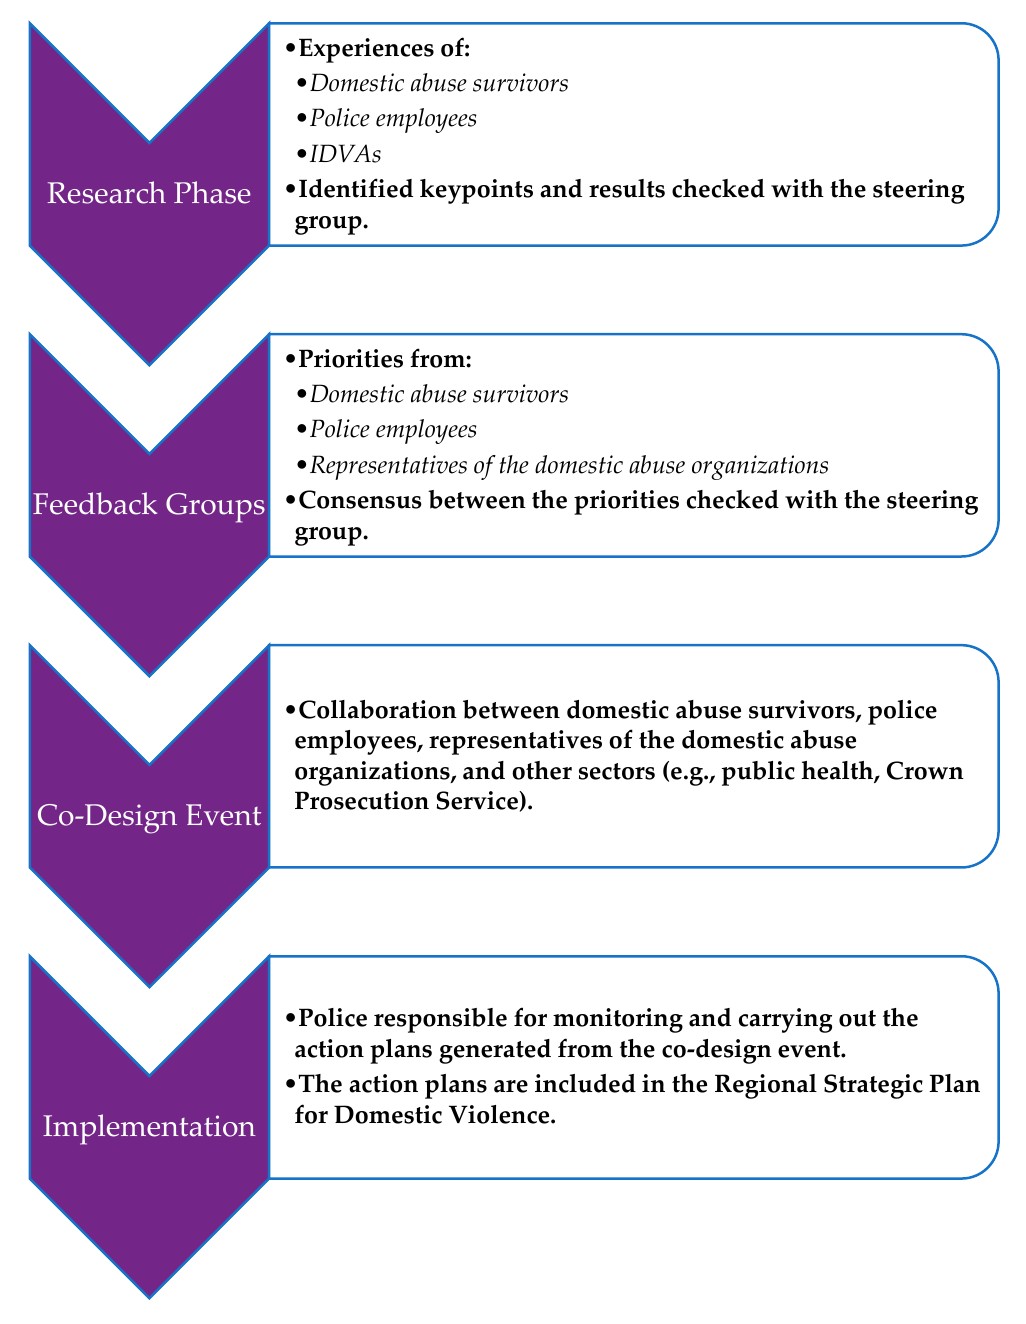
Figure 1. Overview of the EBCD project.